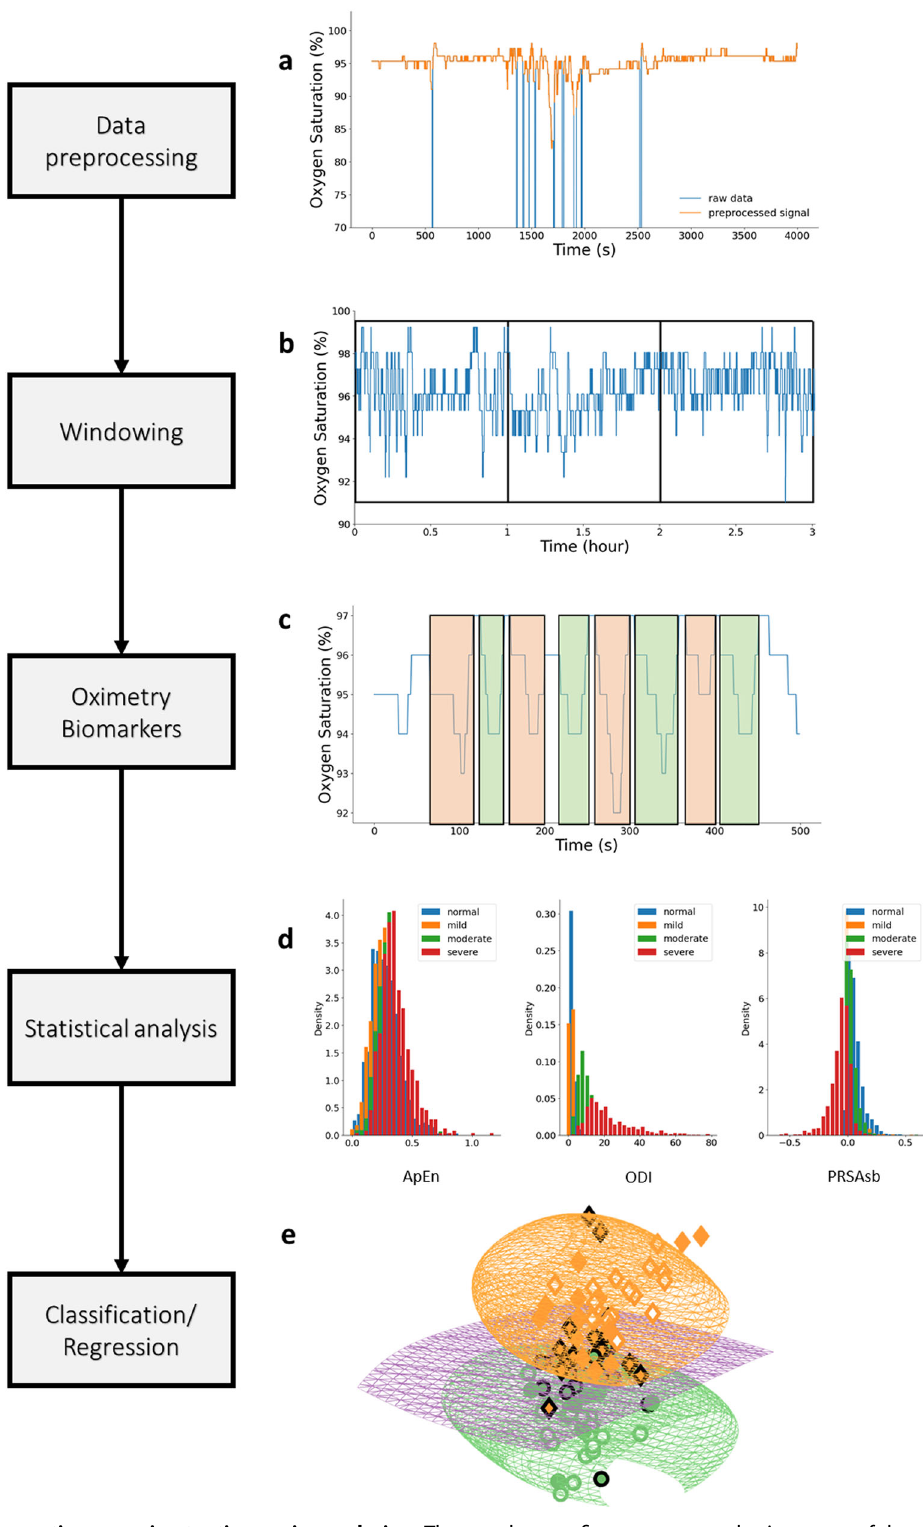
Fig. 3 Flowchart for continuous oximetry time series analysis. a The raw data are fi rst preprocessed using some of the routines presented in section “ Preprocessing ” , to remove any non-physiological values that are likely caused by noise. b The recording is then windowed. The size of the analysis windows and whether to consider overlapping windowing is an important consideration and will be research dependent. c Oximetry biomarkers are then computed using the OBM toolbox. d A statistical analysis is performed to obtain a preliminary understanding of the biomarker behavior for the different classes of interest. e Finally, a machine learning model can be used to combine the biomarkers for a regression or classi fi cation